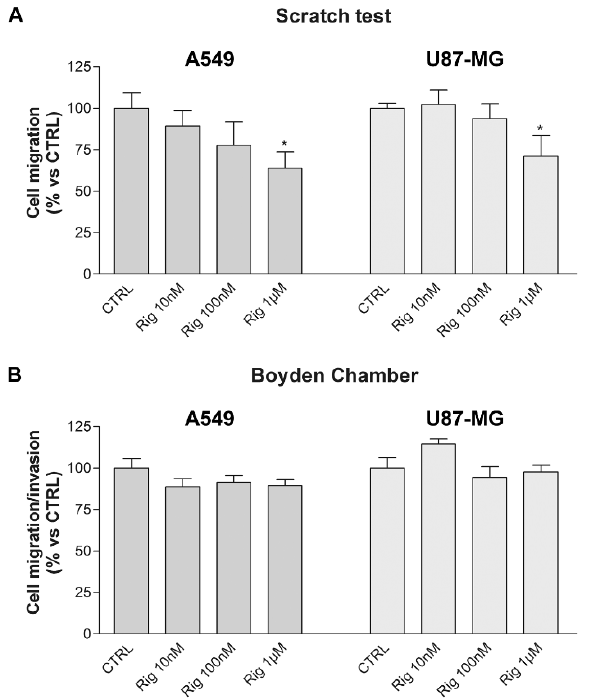
Figure 8. Migration and invasion of A549 and U87-MG cells after Rig treatment. ( A ) 24 h scratch wound healing assay of A549 and U87-MG cells after treatment with increasing concentrations of Rig (Rig 10 nM, 100 nM, and 1 µM). Graphs are represented as the mean percentage ± SD of at least three independent experiments and are compared to untreated controls (CTRL, arbitrarily set to 100%). * p < 0.05. ( B ) Boyden chamber assay of A549 and U87-MG cells after treatment with increasing concentrations of Rig (Rig 10 nM, 100 nM, and 1 µM) for 24 h. Data are normalized on cell viability. * p < 0.05.